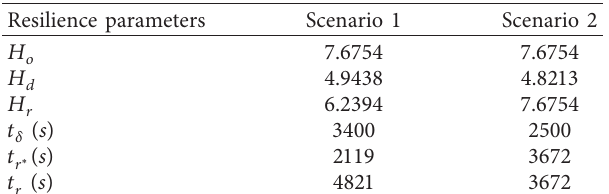
Figure 12: The overall performance of the subway line under scenario 2. Table 1: Resilience parameters of CBTC system under two different scenarios.